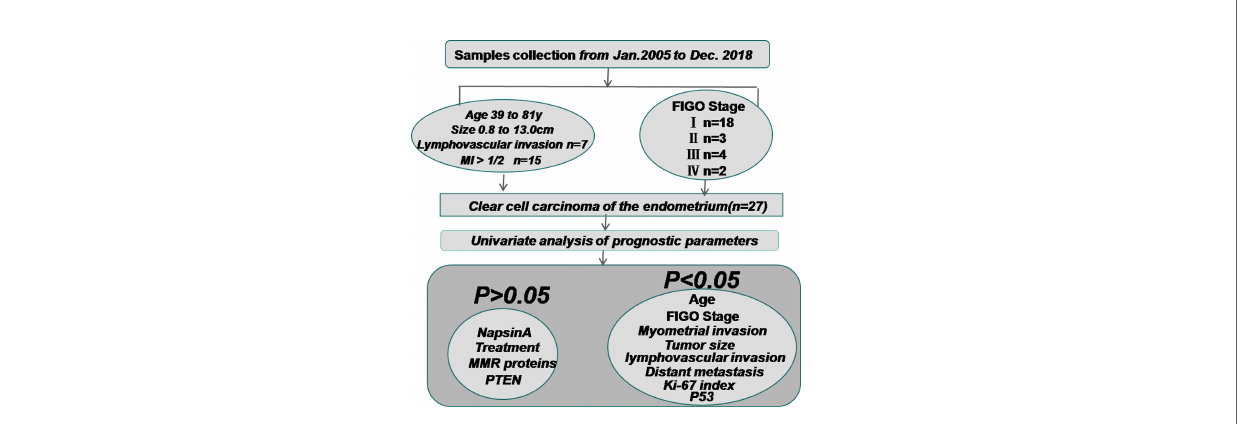
FIGURE 3 | The clinicopathologic features and univariate analysis of prognostic parameters in clear cell carcinoma of the endometrium. Sample collection was approved by the Ethics Committee of the First Af fi liated Hospital of Bengbu Medical College from January 2005 to December 2018. The patients ’ FIGO (2009) surgical stages were as follows: 18 I, 3 II, 4 III, and 2 IV. The average age at diagnosis was 60 years (range: 39 - to 81 years). 7 patients had lymphovascular invasion and 15 patients had MI > 1/2. The Kaplan-Meier method was used for univariate analysis of the prognosis-related factors and OS. Age, FIGO stage, tumor size, MI, Ki-67 index, positive expression of P53, lymphovascular invasion, and distant metastasis of the patients were signi fi cantly associated with shorter OS ((P = 0.048, P < 0.001, P = 0.016, P = 0.043, P = 0.026, P = 0.007, P = 0.001, and P < 0.001 respectively). The positive expression of Napsin A (P = 0.119), adjuvant treatment (P = 0.180), loss of MSH2 (P = 0.472), MSH6 (P = 0.524) and PTEN (P = 0.472) were not statistically associated with OS. MI, myometrial invasion; MMR proteins, mismatch repair